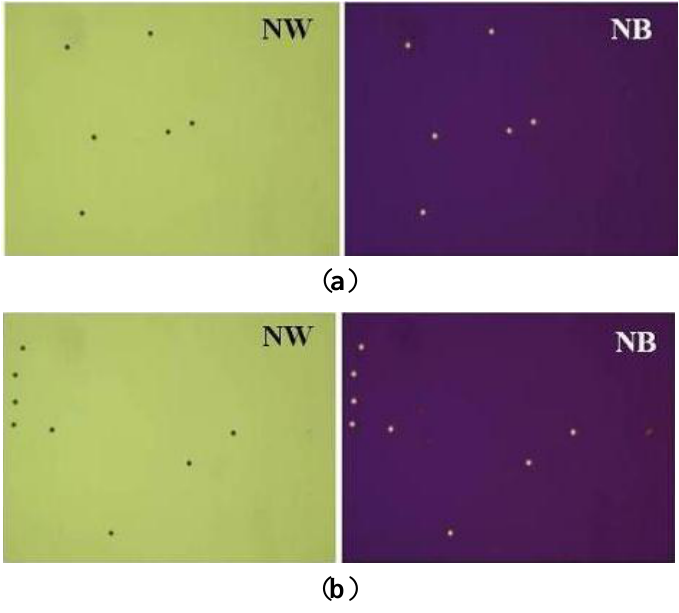
Figure 8. Micrographs of ( a ) an undoped twisted-nematic liquid crystal (TN-LC) cell; and ( b ) a nano-ITO-doped TN-LC cell of 0.2 wt %. The images were obtained from an optical microscope in the normally black (NB) mode and the normally white (NW) mode with a crossed polarized light source; ( c ) SEM micrograph of the original ITO particles. The scale bar for the picture is also